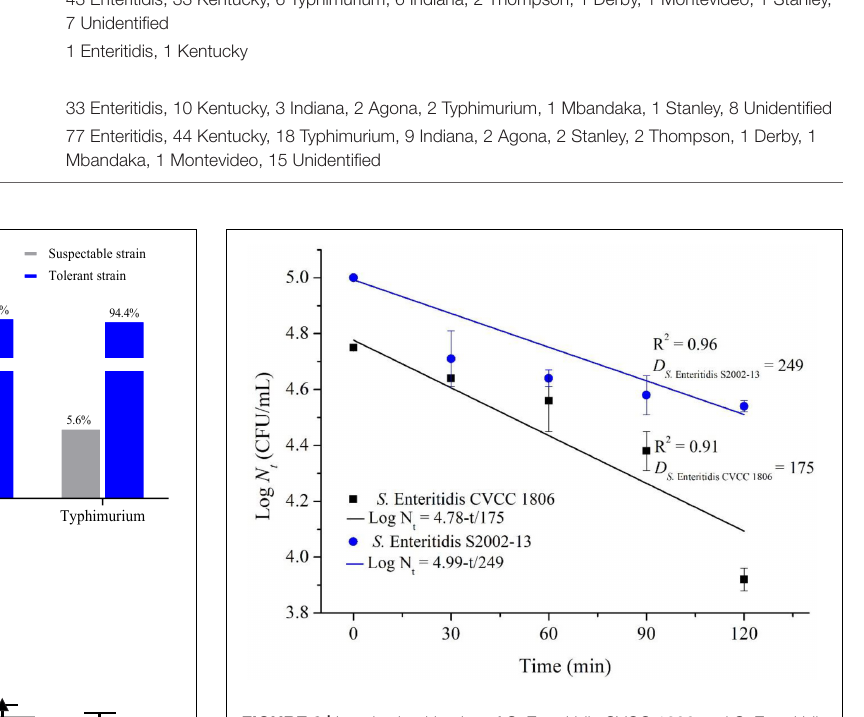
FIGURE 2 | Inactivation kinetics of S. Enteritidis CVCC 1806 and S. Enteritidis S2002-13 exposed to concentration of NaClO at 100 mg/L for 0, 30, 60, 90, and 120